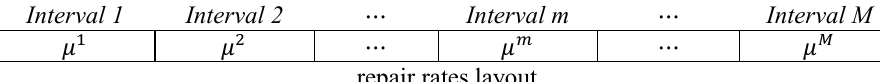
Figure 4. GA chromosome